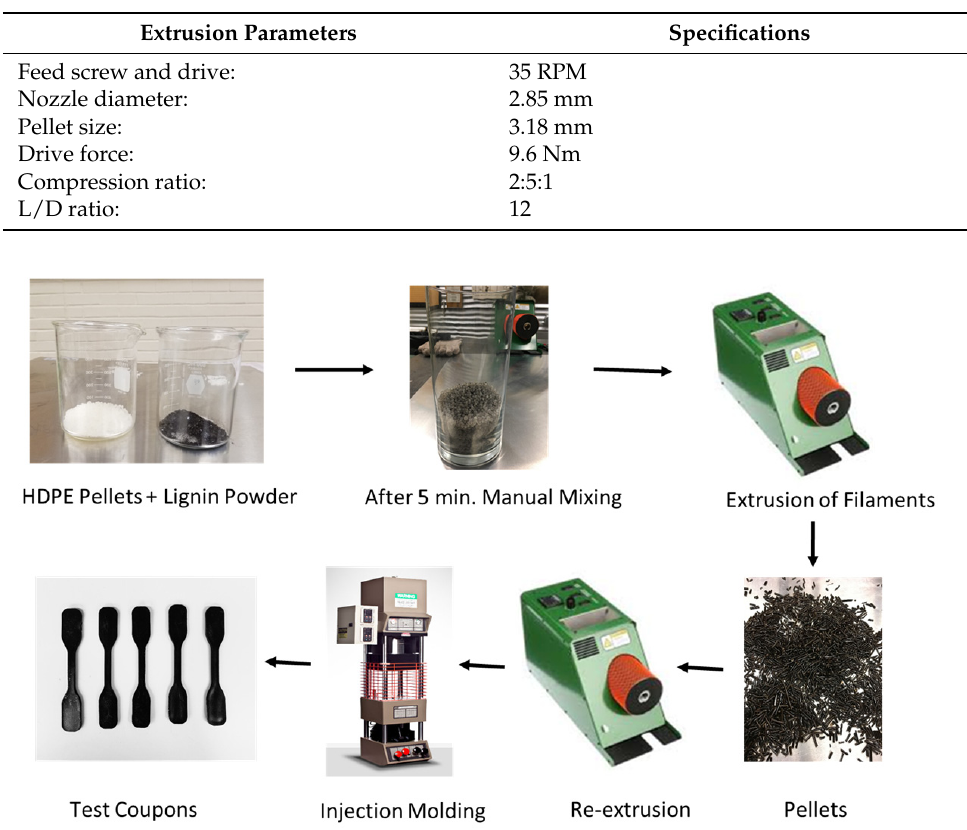
Figure 1. Schematic illustration of sample preparation. Table 1. Extrusion process